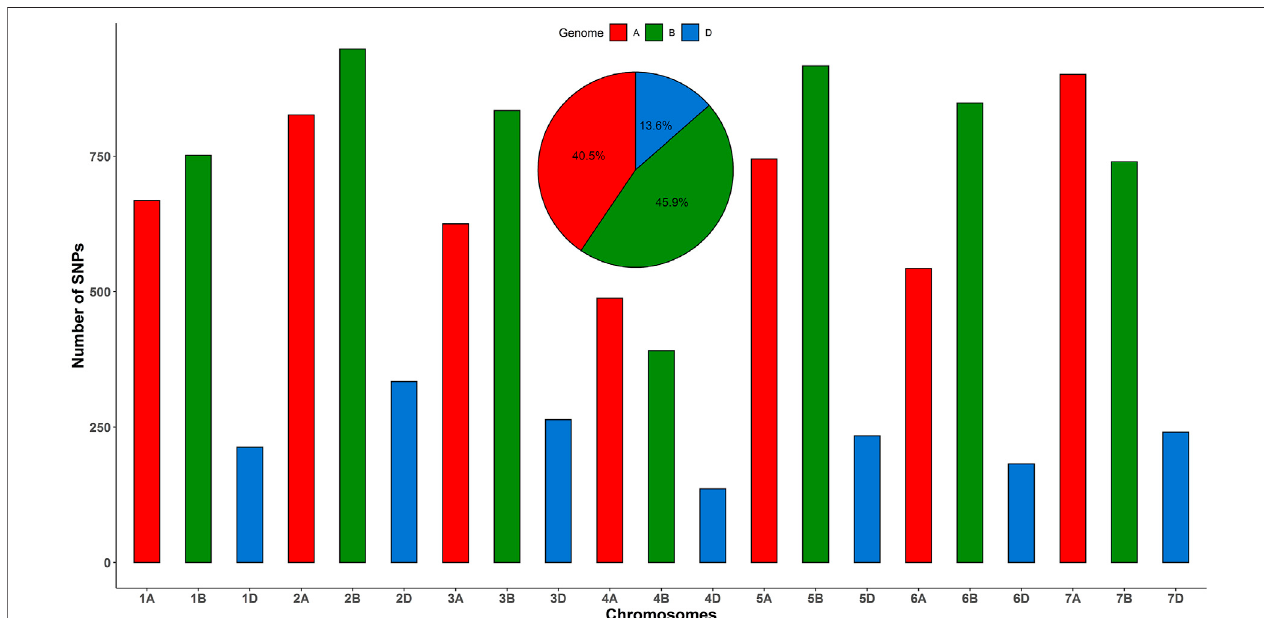
FIGURE 2 | (A) Population structure of 600 bread wheat landraces for k = 2, 3, and 4. Different colors represent the subpopulations, and each bar represents the estimated membership of a single genotype. The horizontal line under the fi gure indicates the geographic origins of the landraces. (B) The scree plot of Δ K against the proportion of explained variance states the optimal subpopulation number in DAPC analysis. (C) The plot of K against Δ K to determine the optimum K value for STRUCTURE analysis. (D) The PCA of 600 bread wheat landraces.